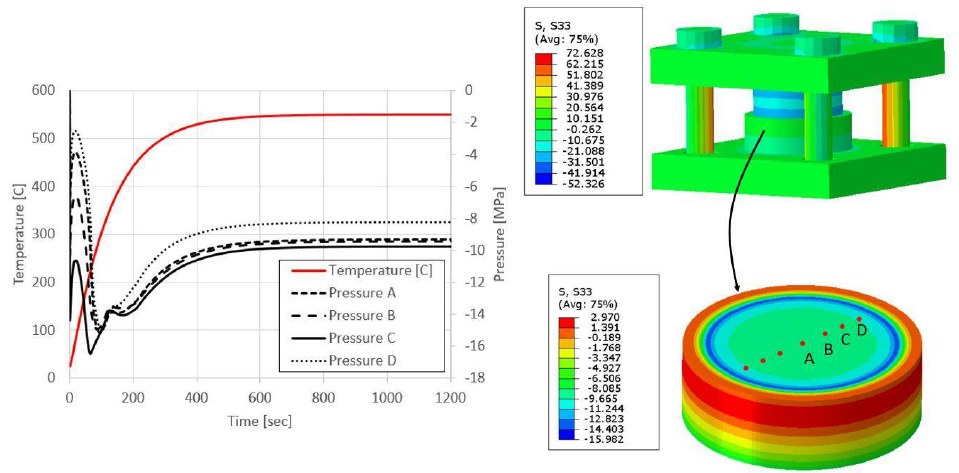
Figure 14. Interface temperature and pressure at different locations (A – D) as a function of time during the bonding process. Table 7. Failure location of the tensile specimens in the second set of